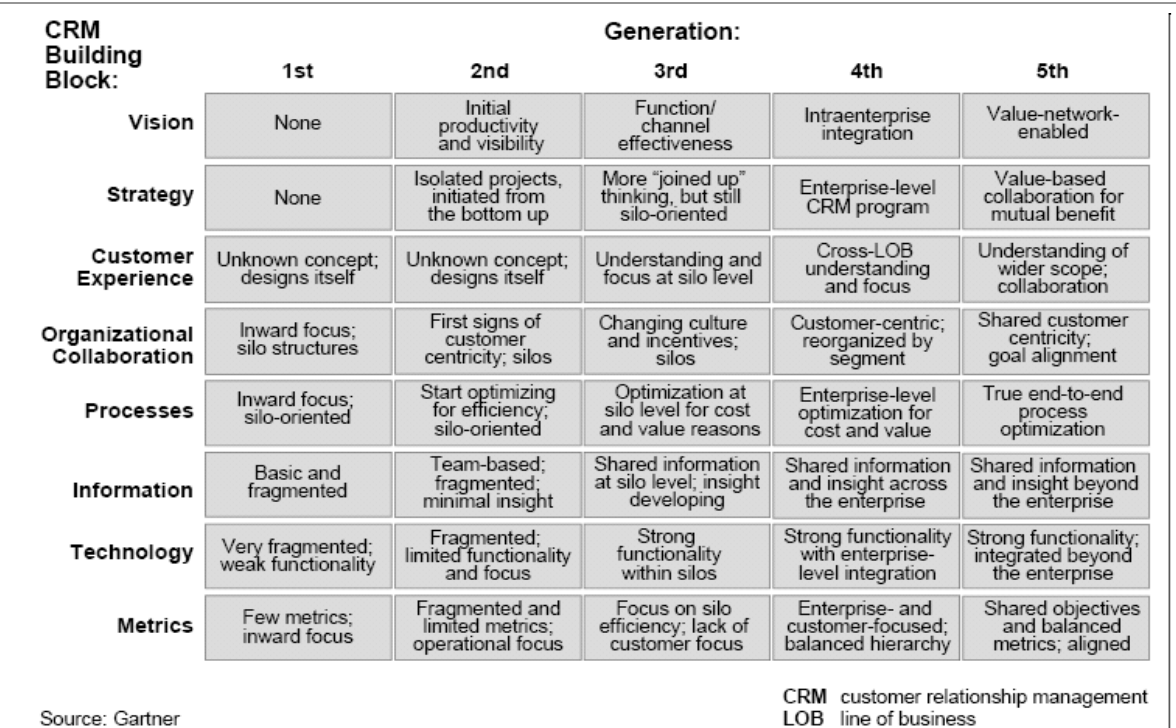
Fig 2. Gartner CRM Generational Framework